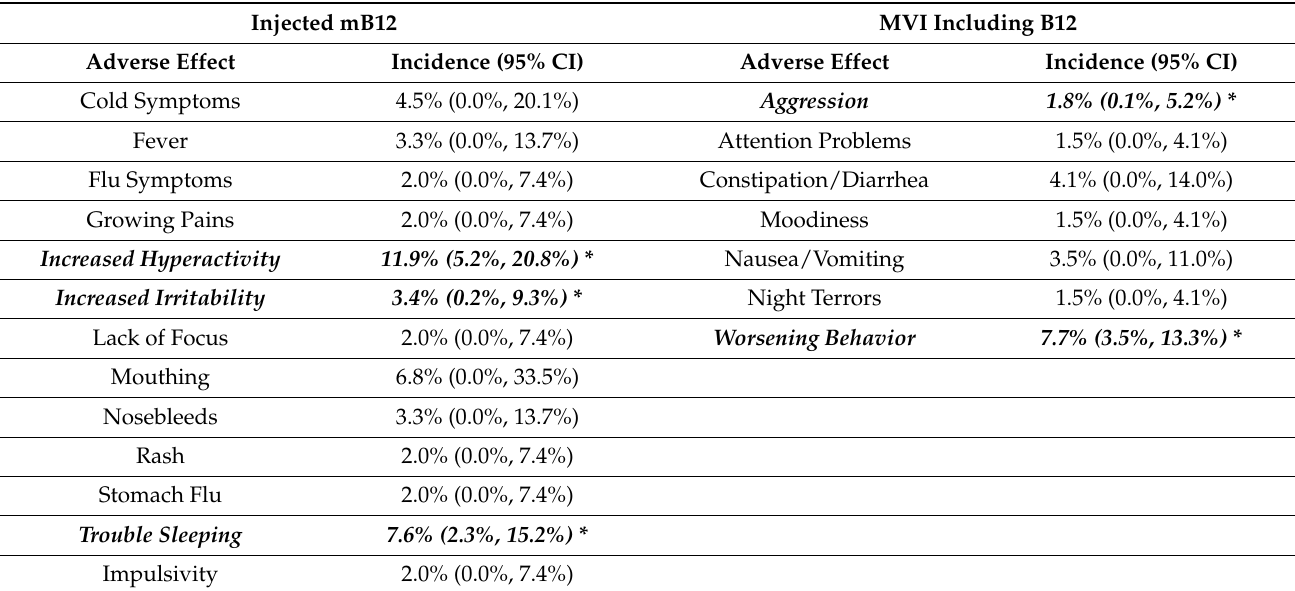
Table 5. Meta-analysis of adverse effects associated with cobalamin in children with ASD. Multivitamin (MVI) * p < 0.05. Adverse effects that were statistically significant are in bold and